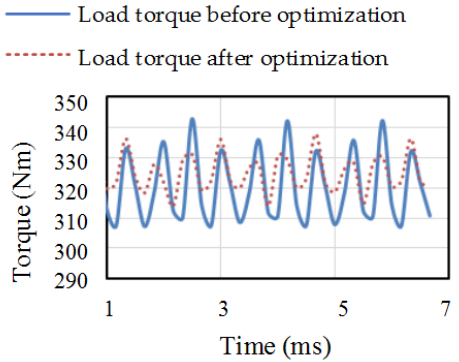
Figure 16. Torque of the AFPMSM at the peak load power.